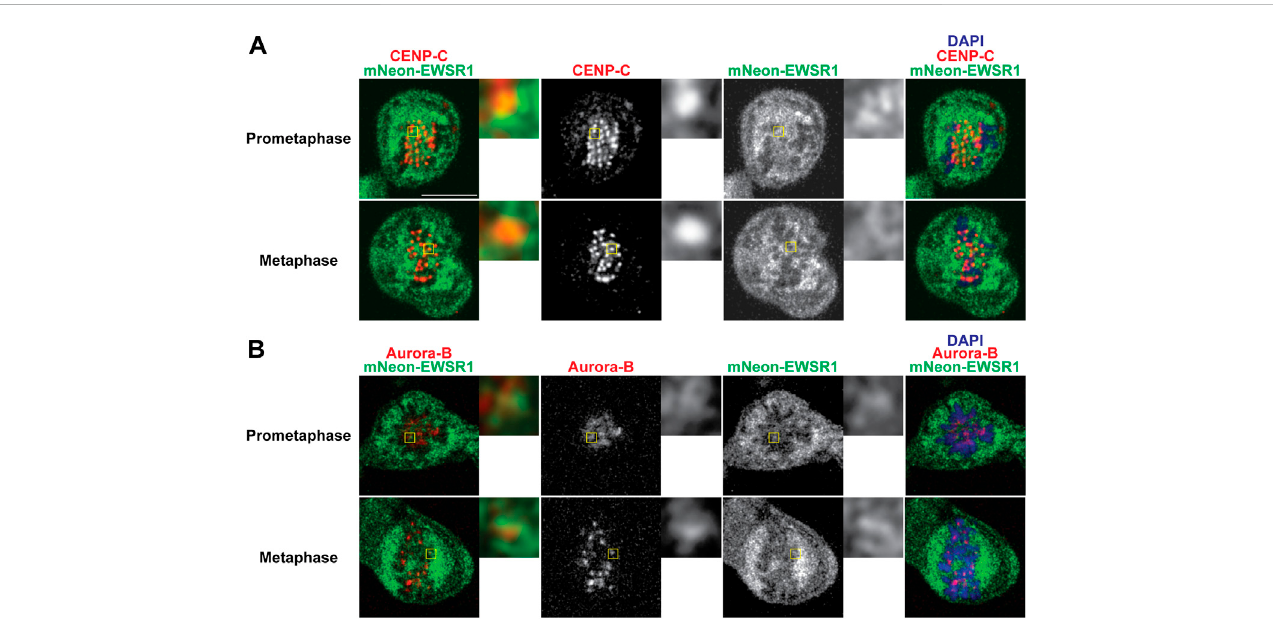
FIGURE 4 EWSR1 partially colocalizes with CENP-C and Aurora B at the kinetochore proximal region in DLD-1 cells. (A) Merged images with CENP-C (Red), mNEON-EWSR1 (Green), and DNA stained using DAPI (blue). CENP-C (red) was visualized using an anti-CENP-C antibody, and mNEON-EWSR1 is shown in green (Left panel); CENP-C (Red) and mNEON-EWSR1 (Green), CENP-C (Red), mNEON-EWSR1 (Green), and DAPI (Right panel). (B) Single Z-section images with Aurora B (Red), mNEON-EWSR1 (Green), and DNA stained using DAPI (blue). Aurora B (red) visualized using anti- CENP-C antibody, and mNEON- EWSR1 (green) (Left panel); Aurora B (Red) and mNEON-EWSR1 (Green), Aurora B (Red), mNEON-EWSR1 (Green), and DAPI (Right panel). Scale bar 10